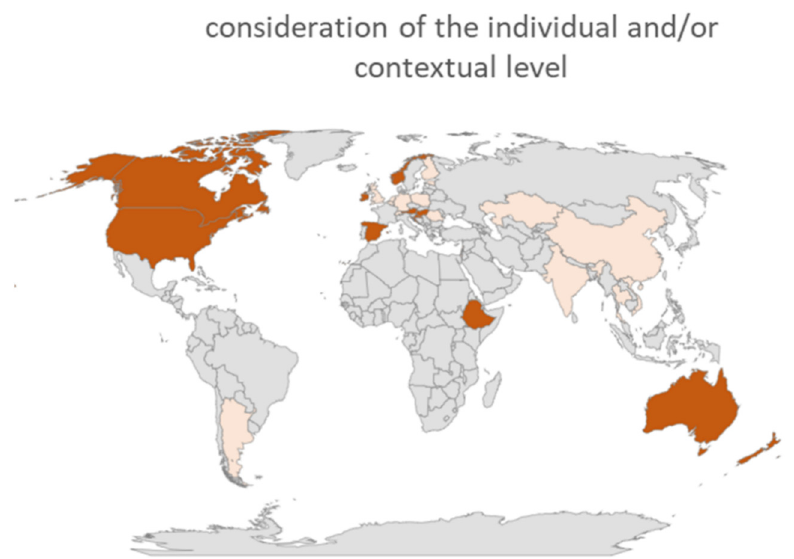
Figure 2. Experts from countries that consider health literacy as an individual concept (light red) or as both an individual and contextual concept (dark red).